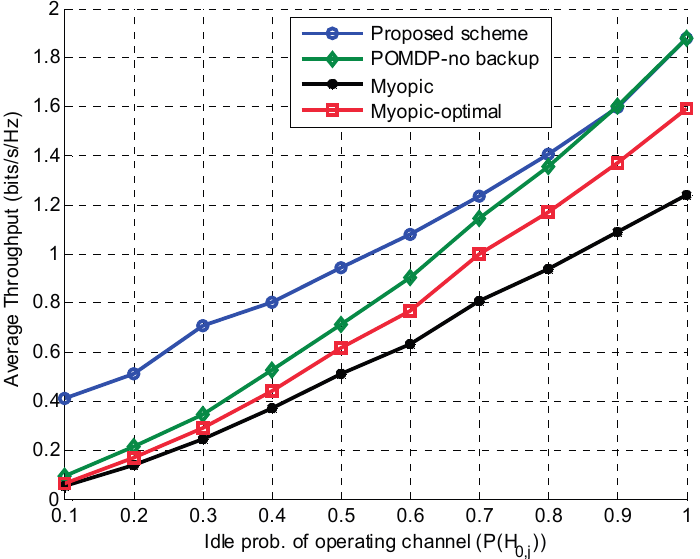
Figure 8. Effect of the operating channel idle probability on average throughput while keeping the backup channel idle probability fixed.